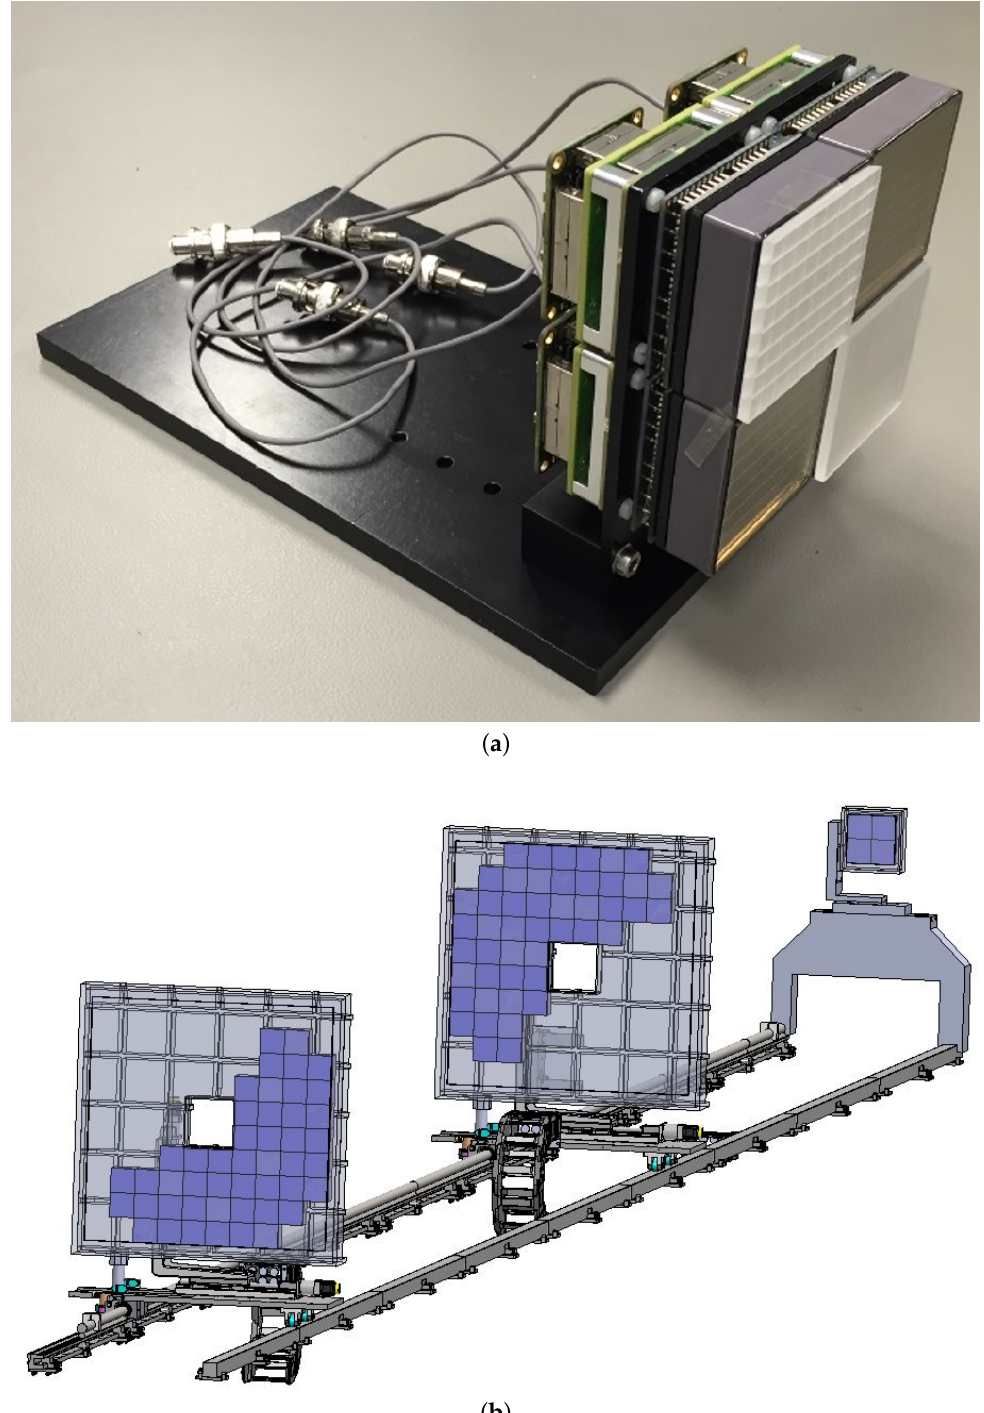
Figure 9. ( a ) Photograph of a 2 × 2 module of a SoNDe type detector. Each tile is 10 × 10 cm in size. ( b ) Arrangement of active area tiles, as shown in ( a ) for the complete detector